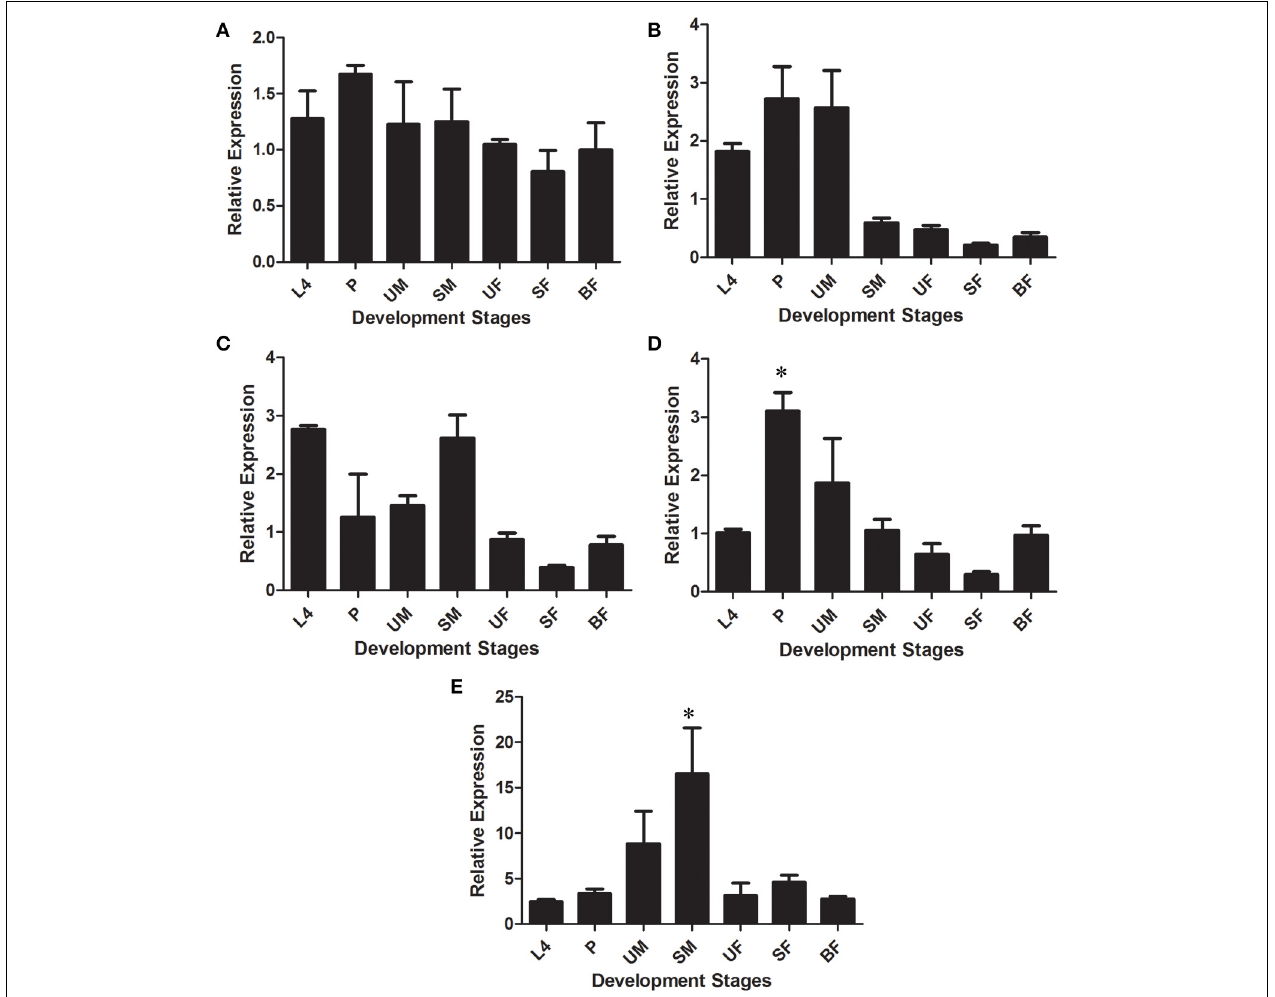
FIGURE 5 | Relative expression of GHF18 members in different stages of development of Lutzomyia longipalpis as determined by Multiplex RT-PCR (Ribosomal protein 60 used as constitutive gene). Chitinases amplified were: (A) LlChit2; (B) LlChit3; (C) LlChit4; (D) LlChit5, and (E) LlIDFG. The experimental groups used in the experiments were larvae (L4),